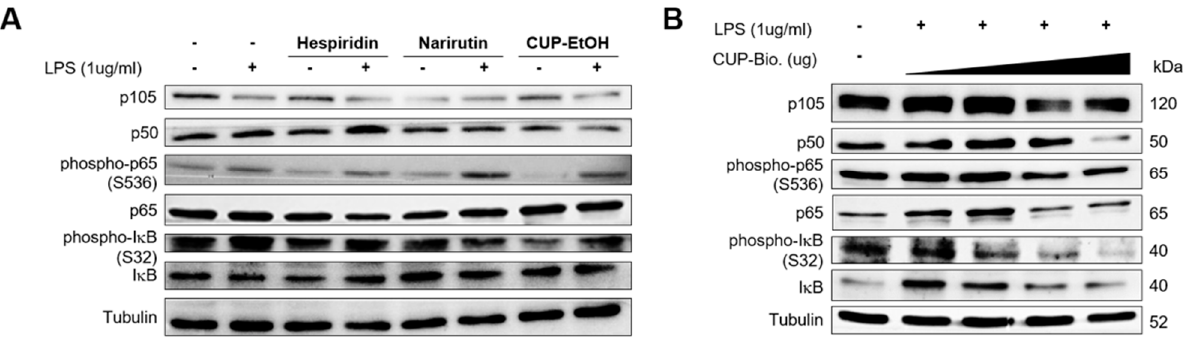
Figure 2. Bioconversion of Citrus unshiu peel (CUP) suppresses nuclear factor (NF)- κ B activation in Caco-2 cells. Immunoblotting analysis of canonical NF- κ B proteins in whole-cell lysates of Caco-2 cells. Caco-2 cells were treated with hesperidin, narirutin (50 μ g/mL), CUP extracted by ethanol (1 mg/mL) ( A ) and bioconversion of CUP (0, 100, 500, and 1000 mg/mL) ( B ) for 1 h, followed by stimulation with LPS (1 μ g/mL) for 2 h. After stimulation, cells were harvested for immunoblotting.